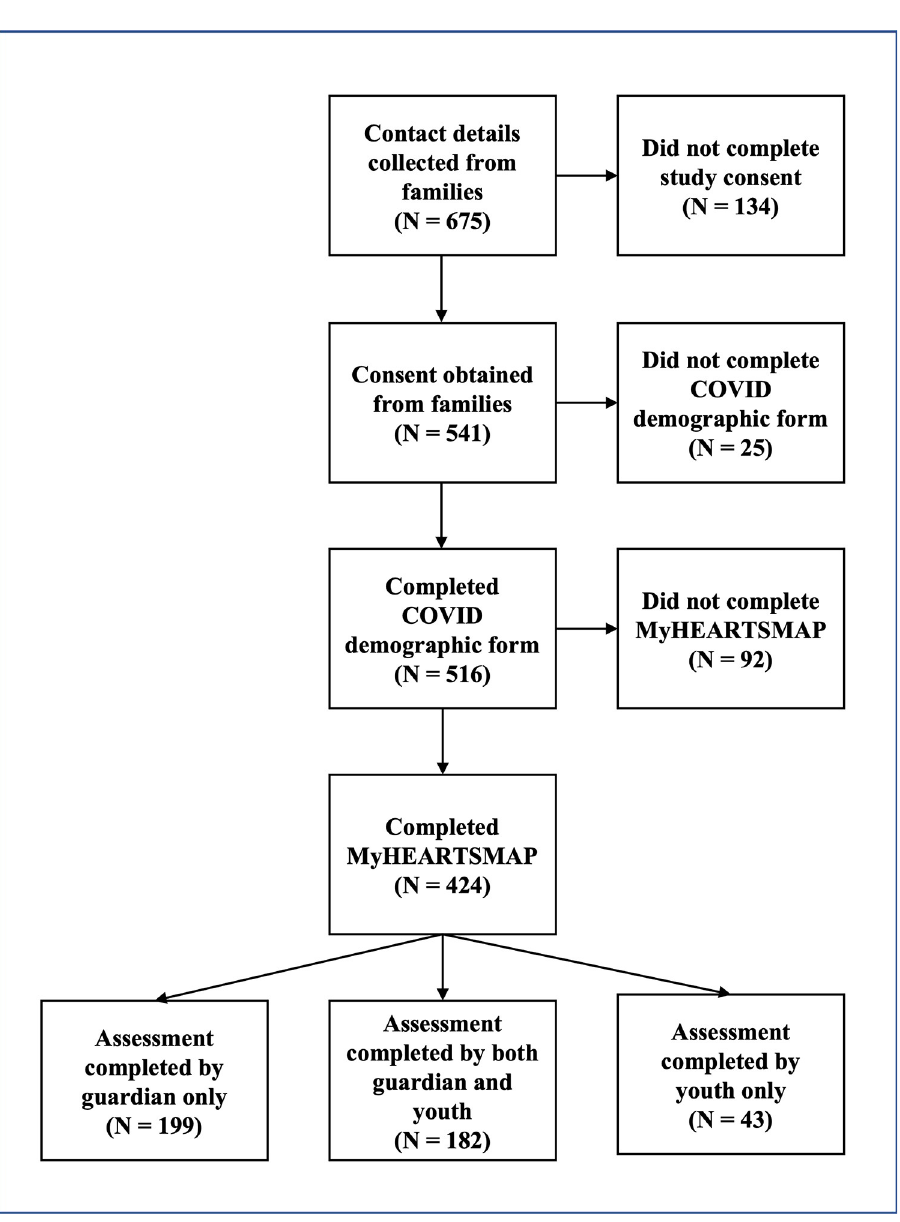
Fig 1. Flowchart of study data collection. proportionality in the psychiatry (p = 0.93) or youth health domains (p = 0.27). There was some evidence of non-proportionality for the social domain (p = 0.04), however this was due to a low number of severe events (n = 4) and given our sample size we felt a multinomial model was not realistic. Older age was associated with greater severity across the psychiatry (OR = 1.29, 95% CI = 1.20, 1.39), social (OR = 1.23, 95% CI = 1.15, 1.33), and youth health (OR = 1.18, 95% CI = 1.10, 1.26) domains. Although a notably small proportion of the sample, youth with nonbinary or questioning gender identity were more likely to have greater severity in the psychiatry (OR = 4.19, 95% CI = 1.07, 16.13) and youth health (OR = 5.03, 95% CI = 1.39, 18.73) domains, while girls were more likely to report greater social difficulty